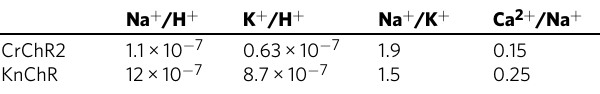
Table 1 Permeability